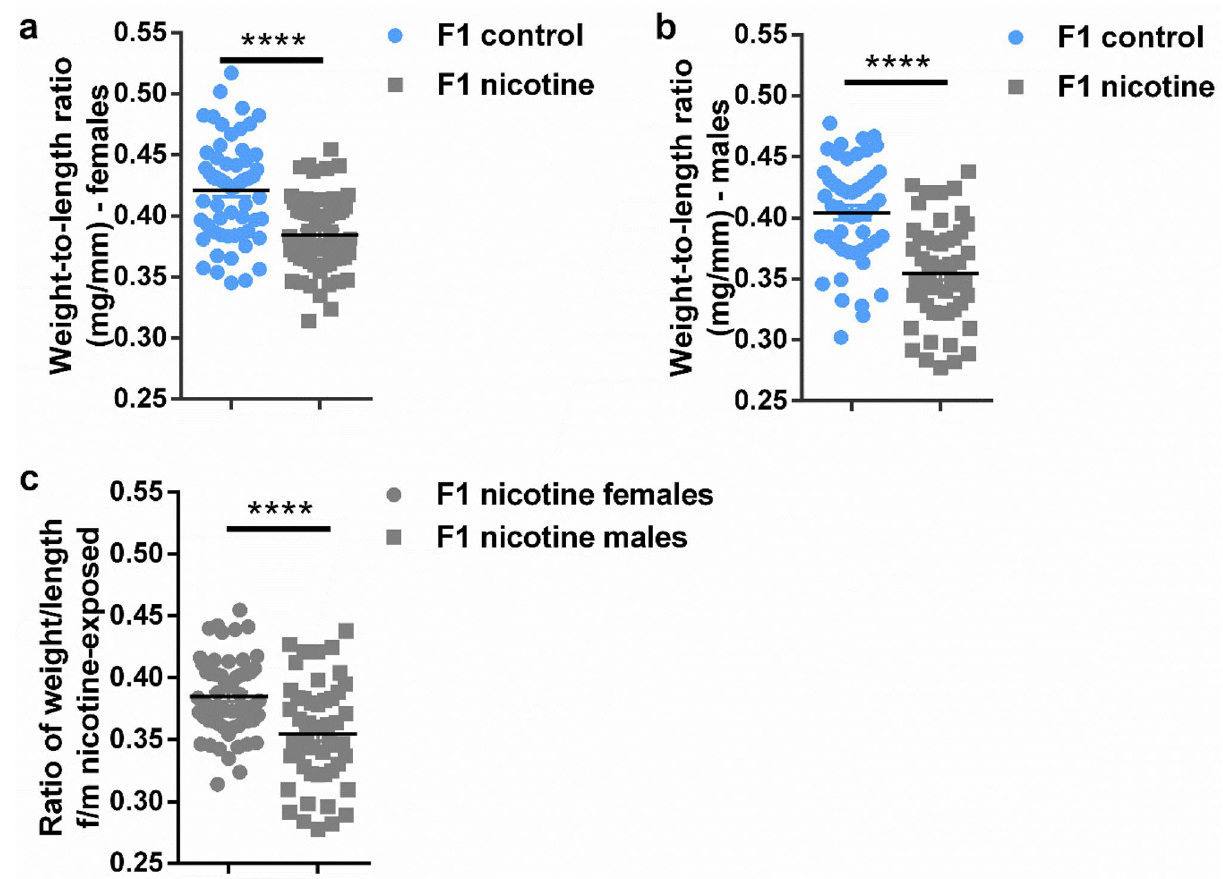
Figure 7. Ratio of weight-to-length in F1 adult flies. ( a , b ) Ratios of weight-to-length in F1 females ( a ) and males ( b ) following the maternal nicotine exposure as compared to the control group. ( c ) ratio of weight- to-length in females/males following the exposure to the maternal e-nicotine only. Values are mean ± SEM, unpaired t-test, ****p < 0.0001, n = 3 independent